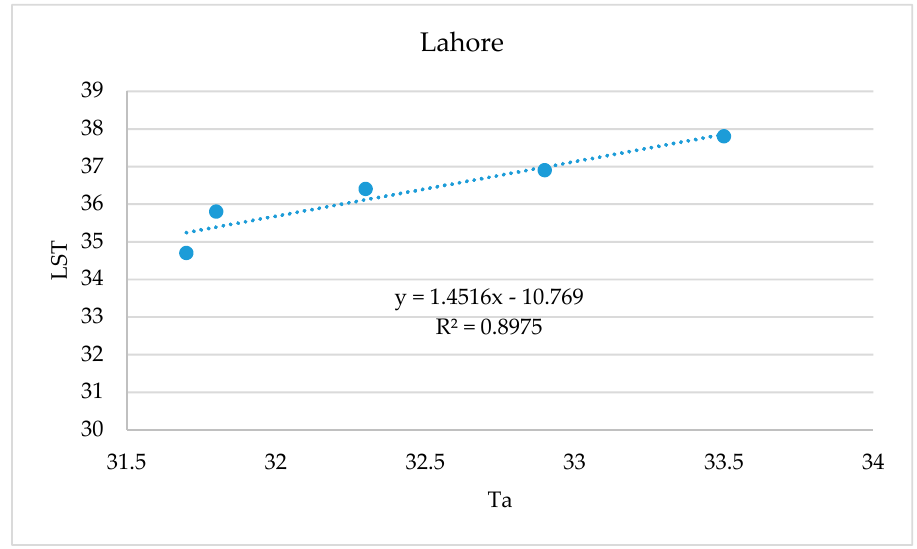
y = 1.4516x - 10.769 R² = 0.8975